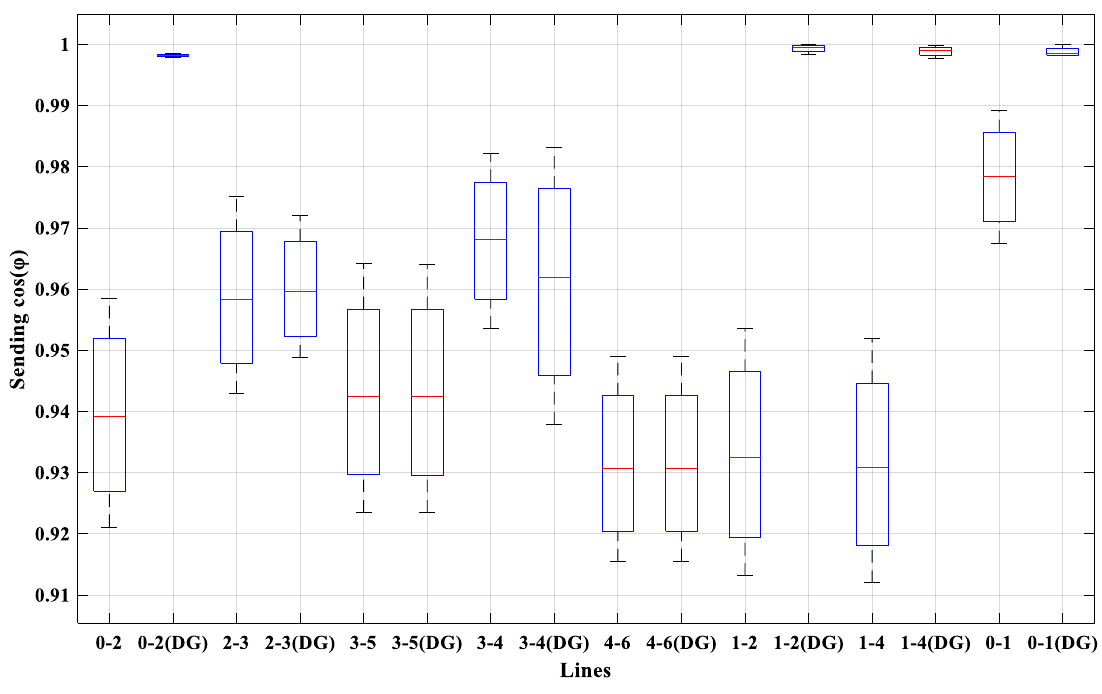
Figure 10. Sending cos(φ) for all transmission lines.